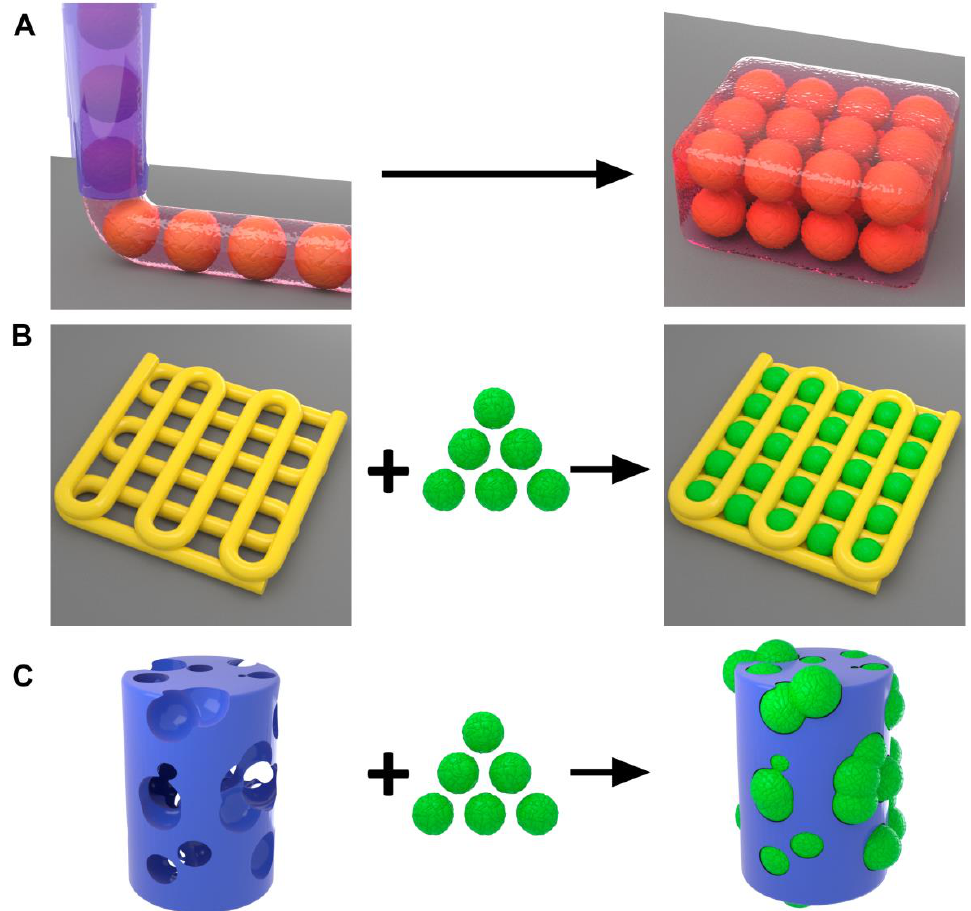
Figure 8. Three methods for biofabrication of mini-scaffolds containing tissue spheroids. ( A ) Bi- oprinting 3D tissue construction from hydrogel (or bioink) containing tissue spheroids. ( B ) Bi- oprinting of scaffolds from hydrogel and inserting tissue spheroids in the bioprinted scaffold holes. ( C ) Bioprinting of scaffolds from solid polymers and inserting tissue spheroids in bioprinted scaf- fold holes.